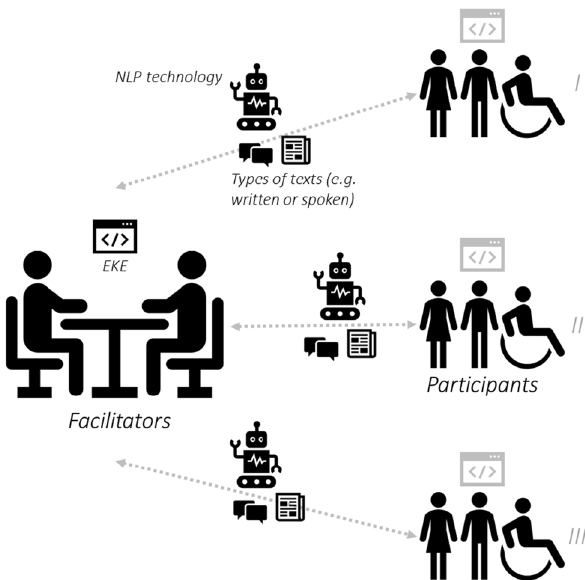
Fig. 3 Illustration of an AI- powered NB method. The numerals I , II , and III represent the order of steps in NB (see Fig. 2). The grey icon above ‘participants’ indicates that EKE could also be performed at that stage in the process (e.g., EKE could be used with the participants to produce more cohesive texts). Facilita- tors use EKE to further parse the NLP outputs and thus arrive at highly informed